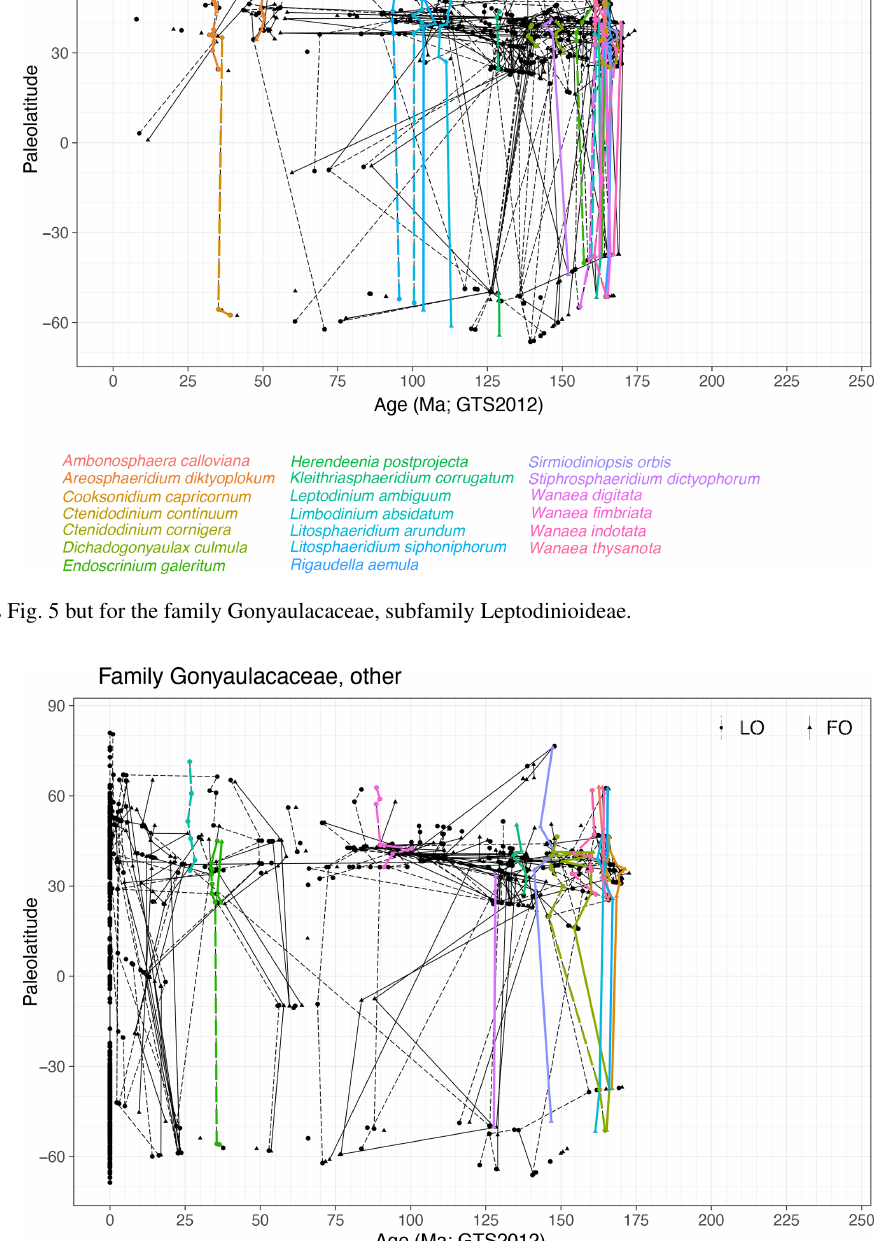
https://doi.org/10.5194/essd-14-579-2022 Earth Syst. Sci. Data, 14, 579–617,